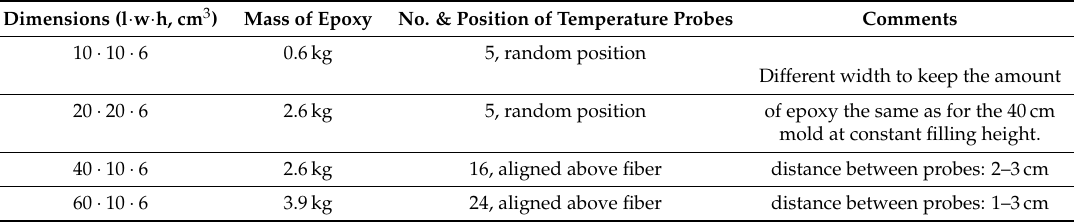
Table 1. Details of the setup for the different experiments. Epoxy Filling height was always